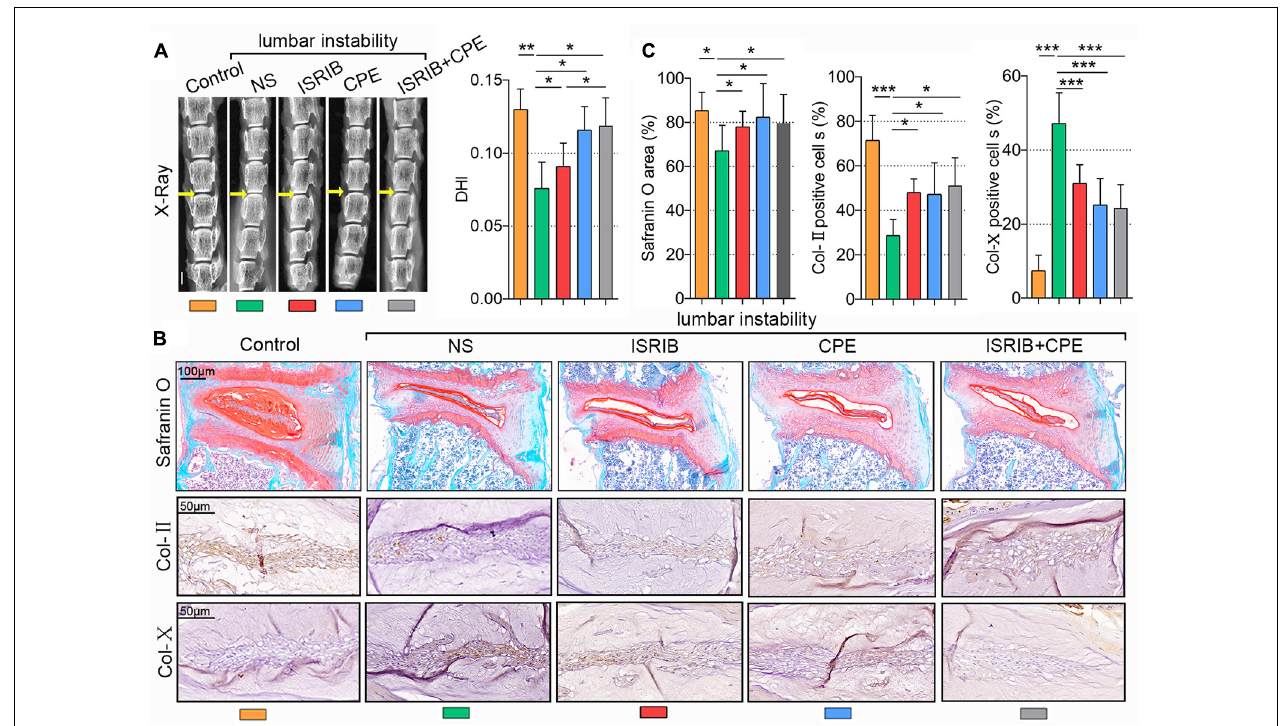
FIGURE 6 | ISRIB and CPE treatment exerted a protective effect on NP cells in vivo . The bilateral inferior articular processes and supra- and interspinous ligaments were transected to induce lumbar instability of mice. Next, the mice were subcutaneously injected with NS, ISRIB, CPE, or the combination with ISRIB and CPE once a day after surgery and sacrificed after 8 weeks of injection. (A) X-ray of the mice lumbar vertebrae, and DHI of the L3–L4 level (scale bar = 2 mm). (B) Representative micrographs of slices stained with Safranin O (scale bar = 100 µ m), Col-II, and Col-X (scale bar = 50 µ m), and (C) quantitation of percentage of total positive area or cells (%). Data are presented as means ± SD ( n = 6). * p < 0.05; ** p < 0.01; *** p < 0.001; the orange column indicates control mice without lumbar instability surgery, the green column indicates mice injected with NS after lumbar instability surgery, the red column indicates mice injected with ISRIB after lumbar instability surgery, the blue column indicates mice injected with CPE after surgery, and the gray column indicates mice injected with ISRIB and CPE after lumbar instability surgery. CPE, cyclopamine; NP, nucleus pulposus; NS, normal saline; DHI, disc height index; Col-II, collagen II; Col-X, collagen